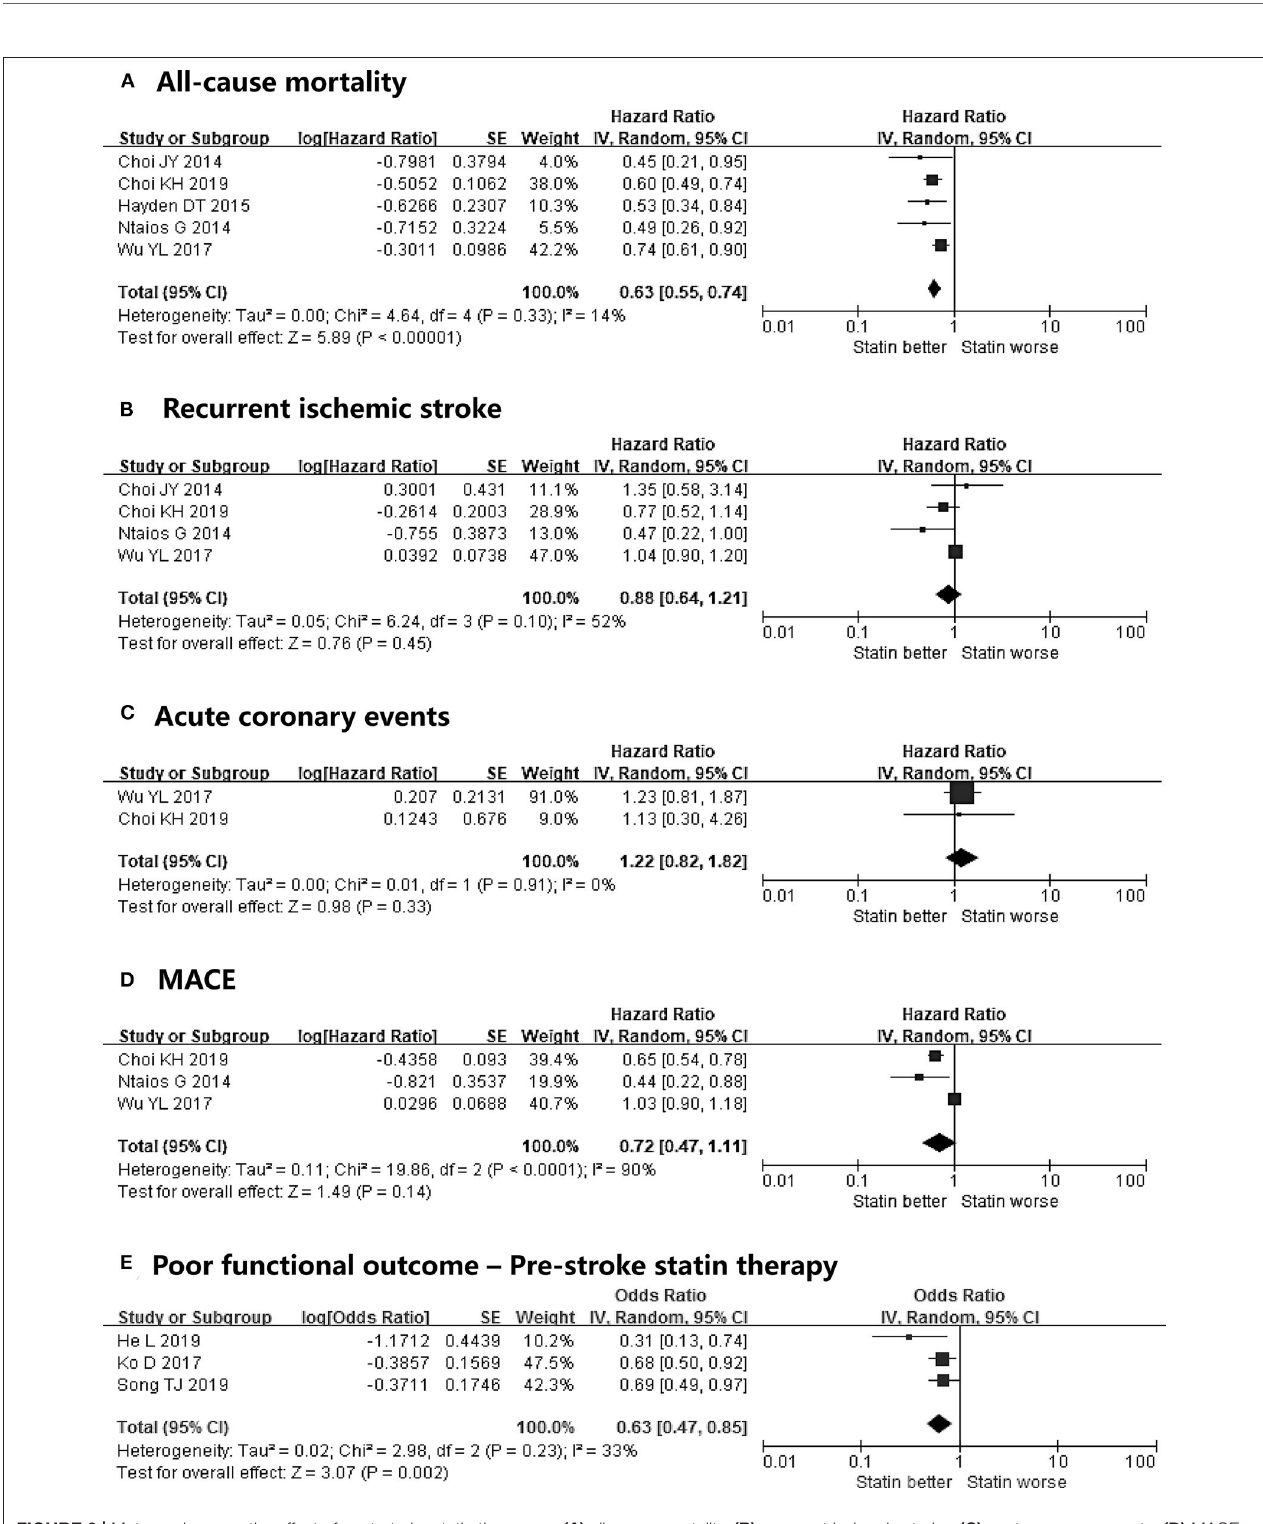
FIGURE 2 | Meta-analyses on the effect of post-stroke statin therapy on (A) all-cause mortality, (B) recurrent ischemic stroke, (C) acute coronary events, (D) MACE, and meta-analysis on the effects of pre-stroke statin therapy on (E) poor functional outcomes in patients with atrial fibrillation-related stroke. MACE, major adverse cardiovascular